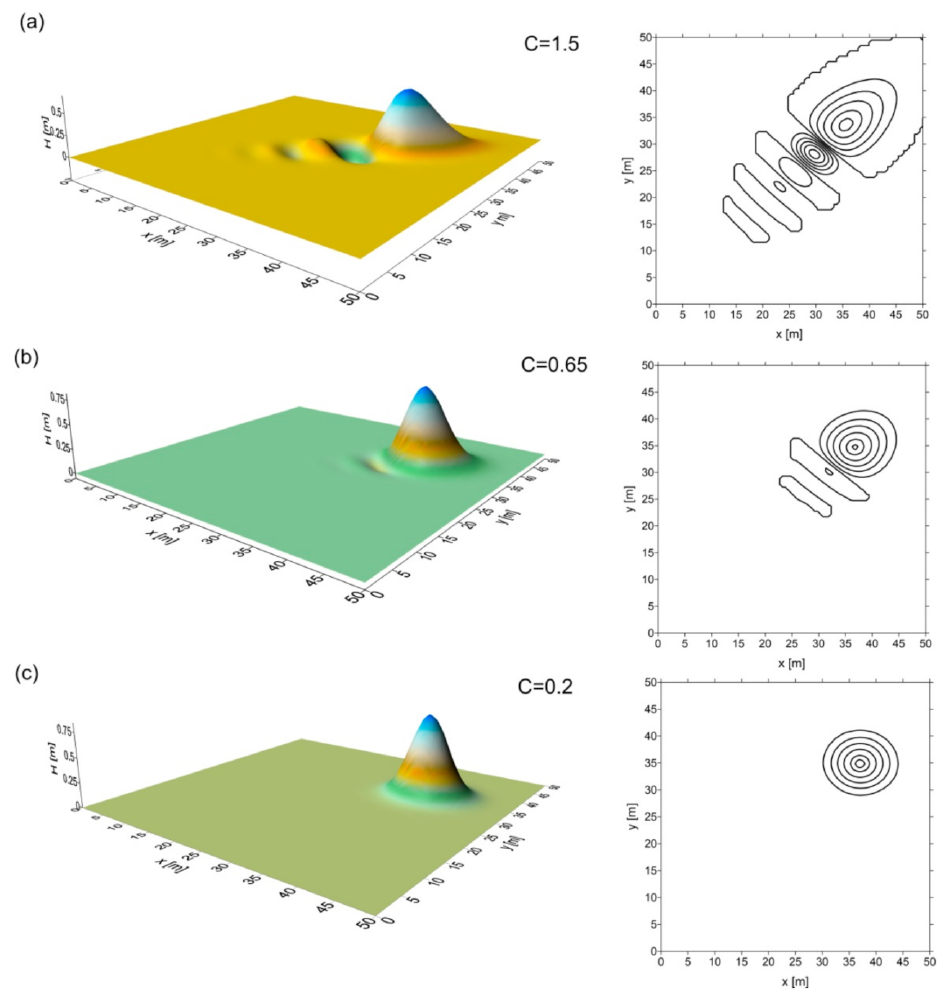
Figure 10. Solution obtained using the 6N mesh with θ = 1/2 and α = 1/2 for various values of the Courant number: ( a ) C = 1.5; ( b ) C = 0.65; ( c ) C =